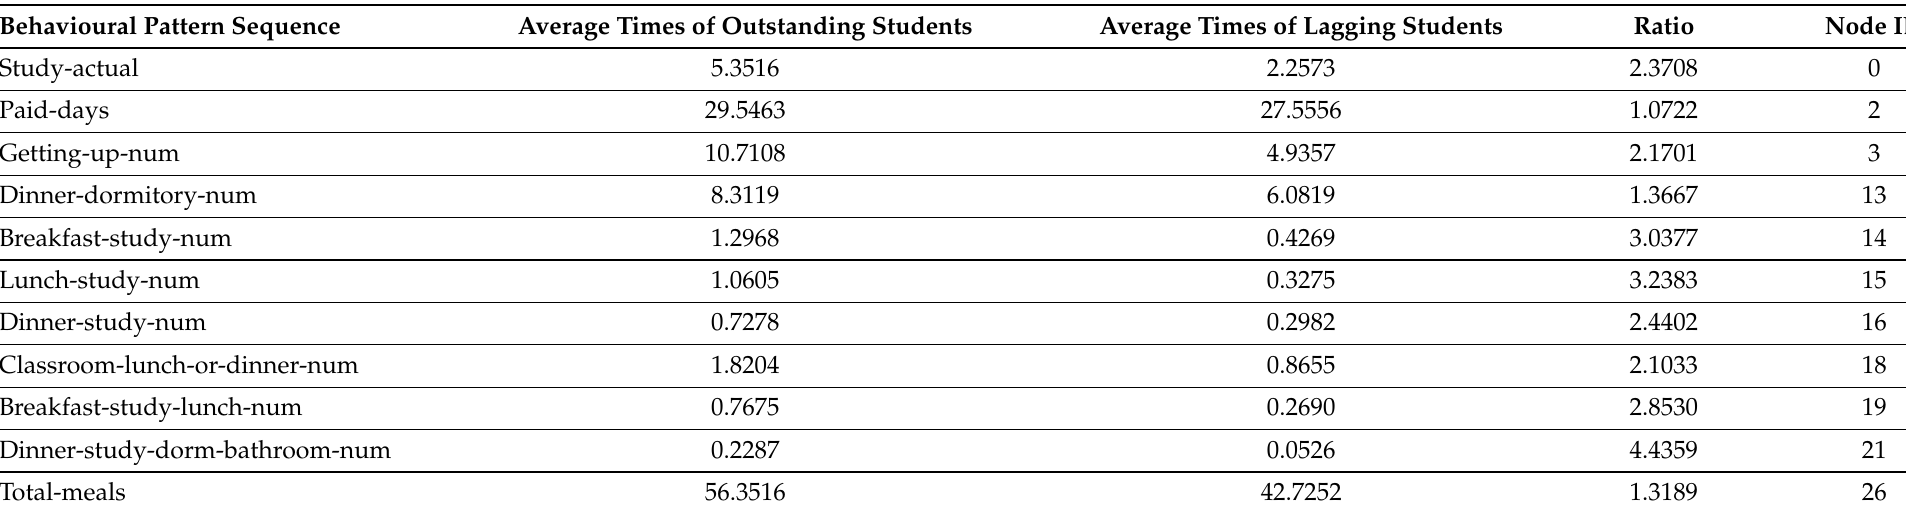
Table 6. Ratio of occurrences of different discriminative behavioural patterns in the two category classification